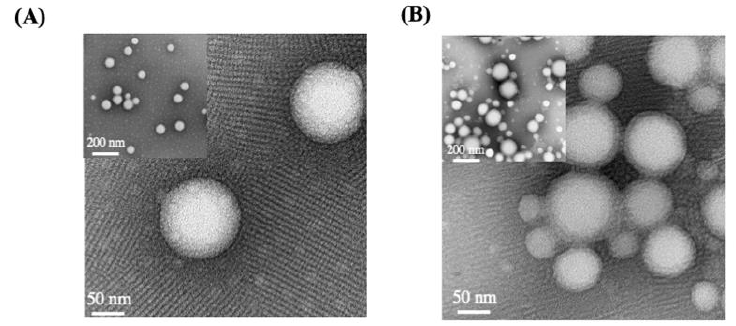
Figure 3. TEM images of; ( A ) PTR-701Ns and ( B )